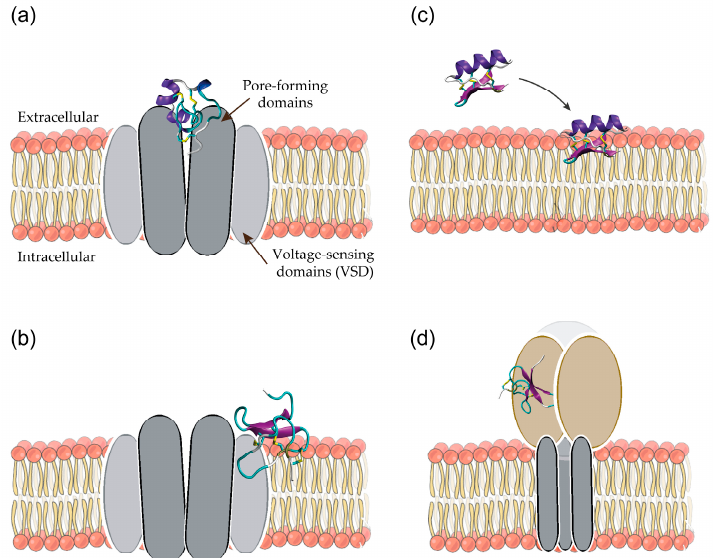
Figure 2. Schematic representation of binding sites and mechanisms of action for disulfide-rich venom peptides acting on voltage-gated ion channels ( a , b ) and acid sensing ion channels (ASICs) ( d ). ( a ) Pore blockers prevent ion conduction by binding to the pore-forming domains; ( b ) Gating modifiers alter the gating behaviour by binding to the voltage-sensing domains; ( c ) The mechanism of some gating modifiers involves the binding of the peptide to the cell membrane; ( d ) Most disulfide-rich venom peptides that inhibit ASICs bind to the large extracellular domain.